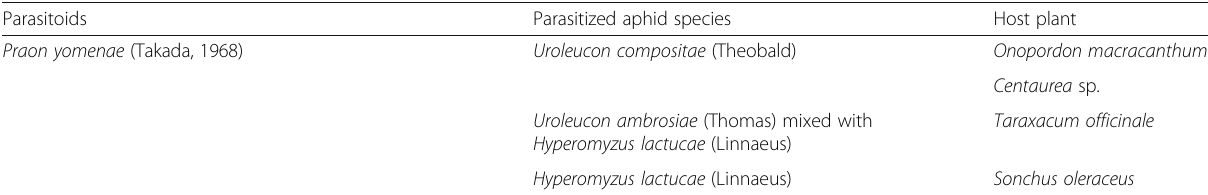
Table 1 Tri-trophic associations, plant-aphid-parasitoid, noted at the oasis ecosystems in the region of Biskra between 2014